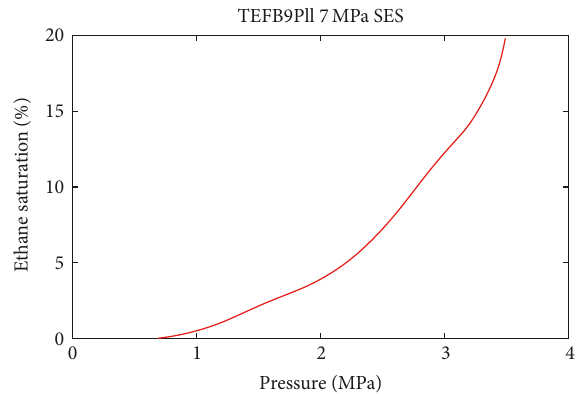
Figure 10: Liquid/semiliquid ethane saturation curve for sample TEFB9Pll at 7 MPa simple effective